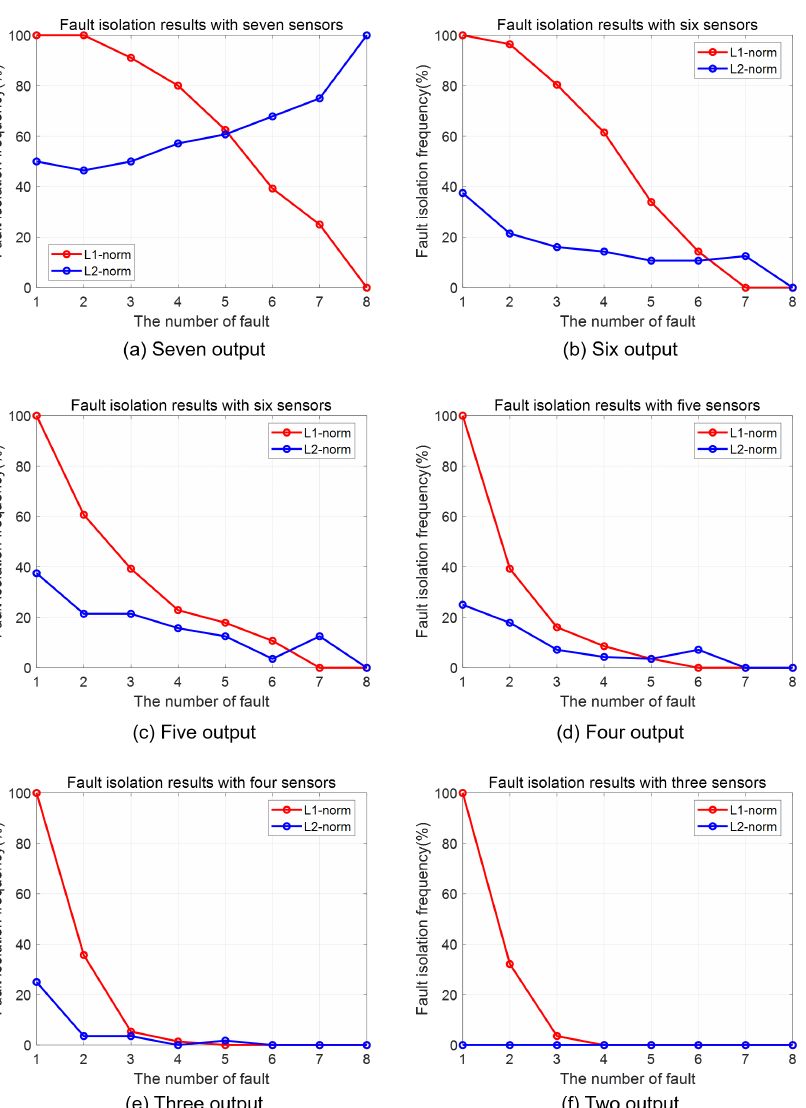
Figure 12. The exact fault isolation rates of the two compares methods for different numbers of outputs and faults. ( a ) V y , γ , a x , u 2 , u 4 , u 5 , u 6 , ( b ) V y , γ , a x , u 2 , u 4 , u 5 , ( c ) V y , γ , a x , u 2 , u 4 , ( d ) V y , γ , a x , u 2 , ( e ) V y , γ , a x , and ( f ) V y , γ output